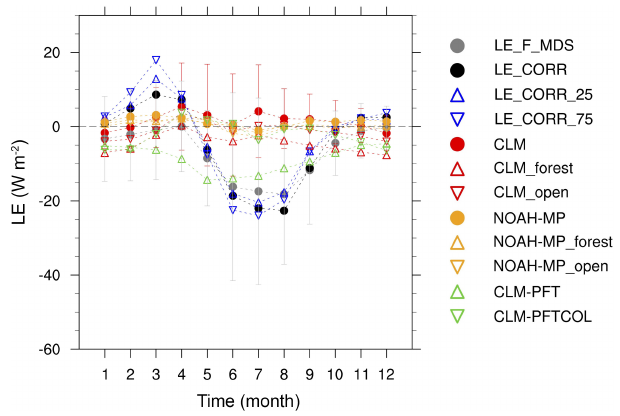
Figure 4. Change in the seasonal cycle of LE (Wm − 2 ) due to LULCC from forest to open land (open −